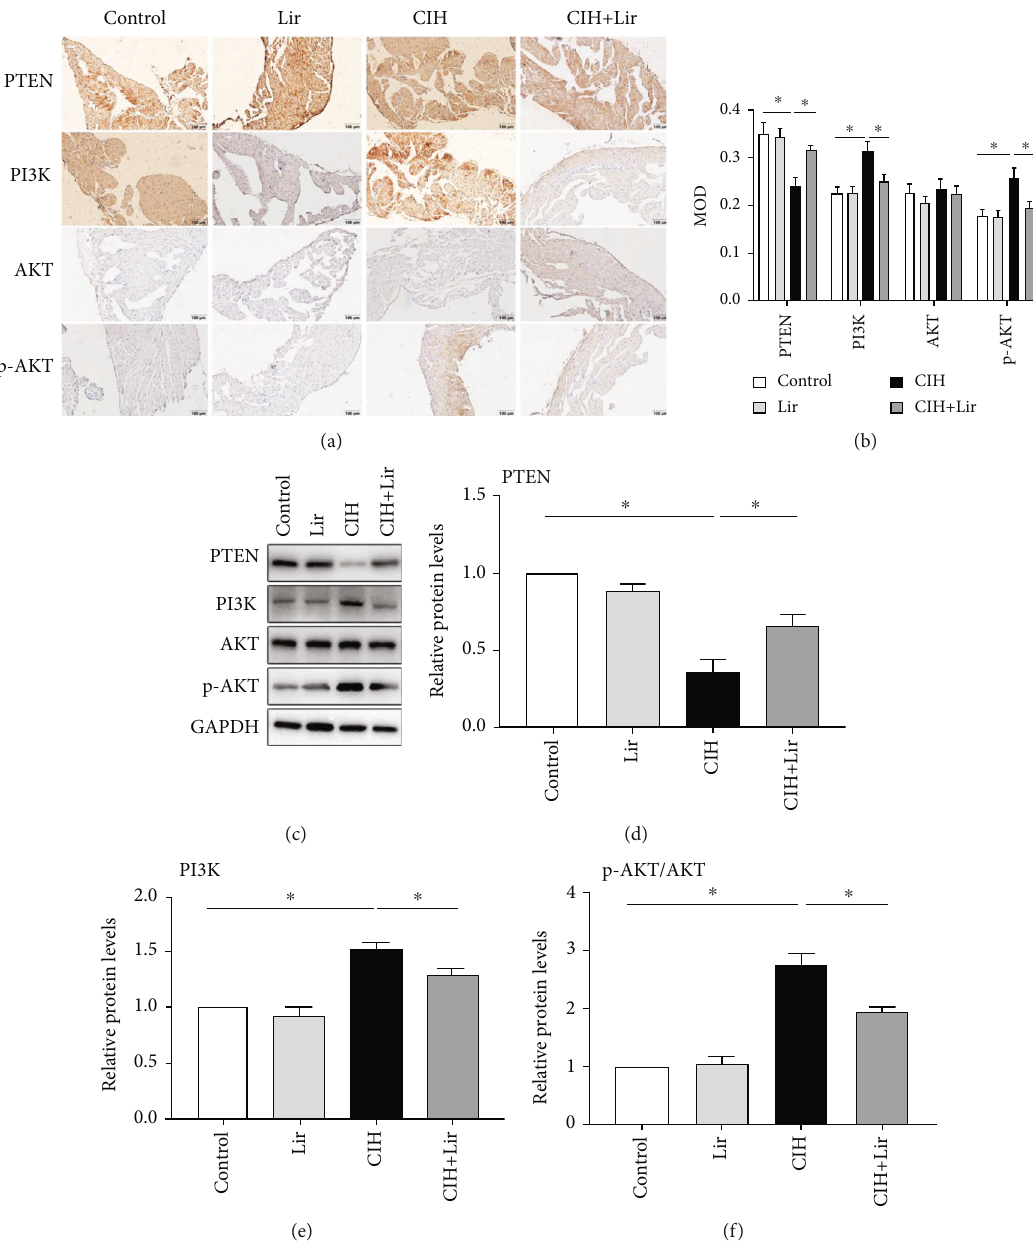
Figure 6: The e ff ect of Lir on the PTEN/PI3K/AKT signaling pathways. (a) Representative photomicrographs of IHC-stained atrial sections from mice in four groups. The positive reaction primarily referred to the brown-yellow granules in the atrial tissues, the number and darkness of granules bespoken the expression levels of target proteins. (b) Mean option density (MOD) in four groups ( n = 6 ). (c – f) Western blot analysis of the expression of PTEN, PI3K, and p-AKT/AKT in four groups ( n = 6 ). Data are mean ± SEM , ∗ P < 0 : 05